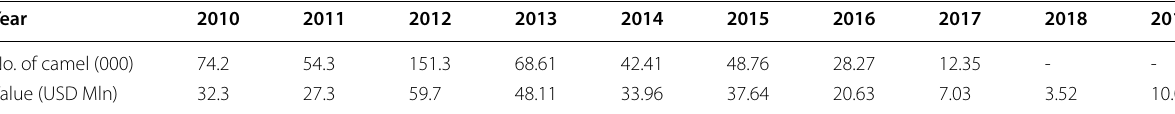
Source: ERCA, export data cited in Mamo,